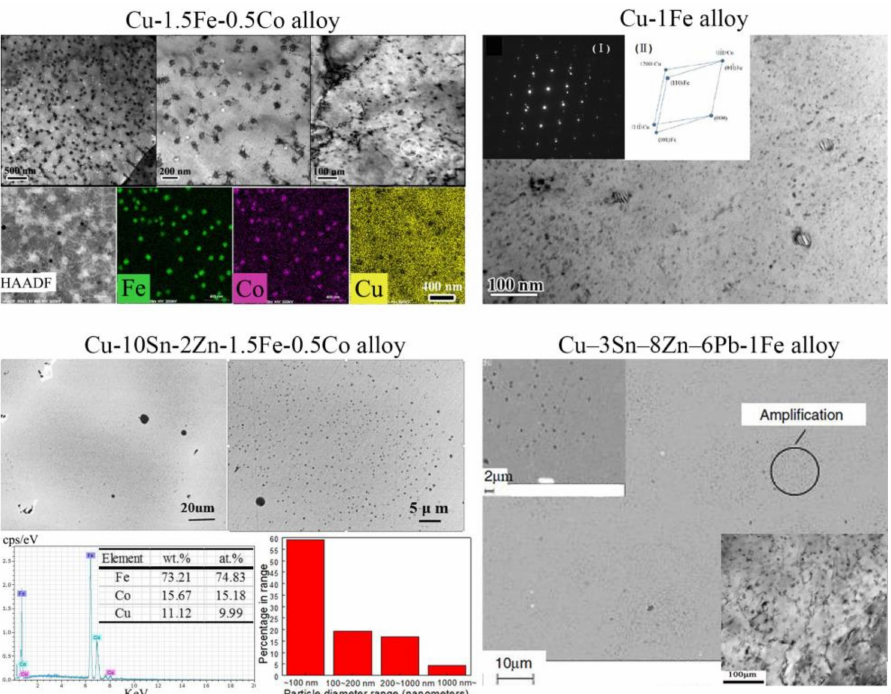
Figure 11. SEM and TEM micrographs of in-situ nanoparticles in as-cast Cu-1.5Fe-0.5Co alloy [69],